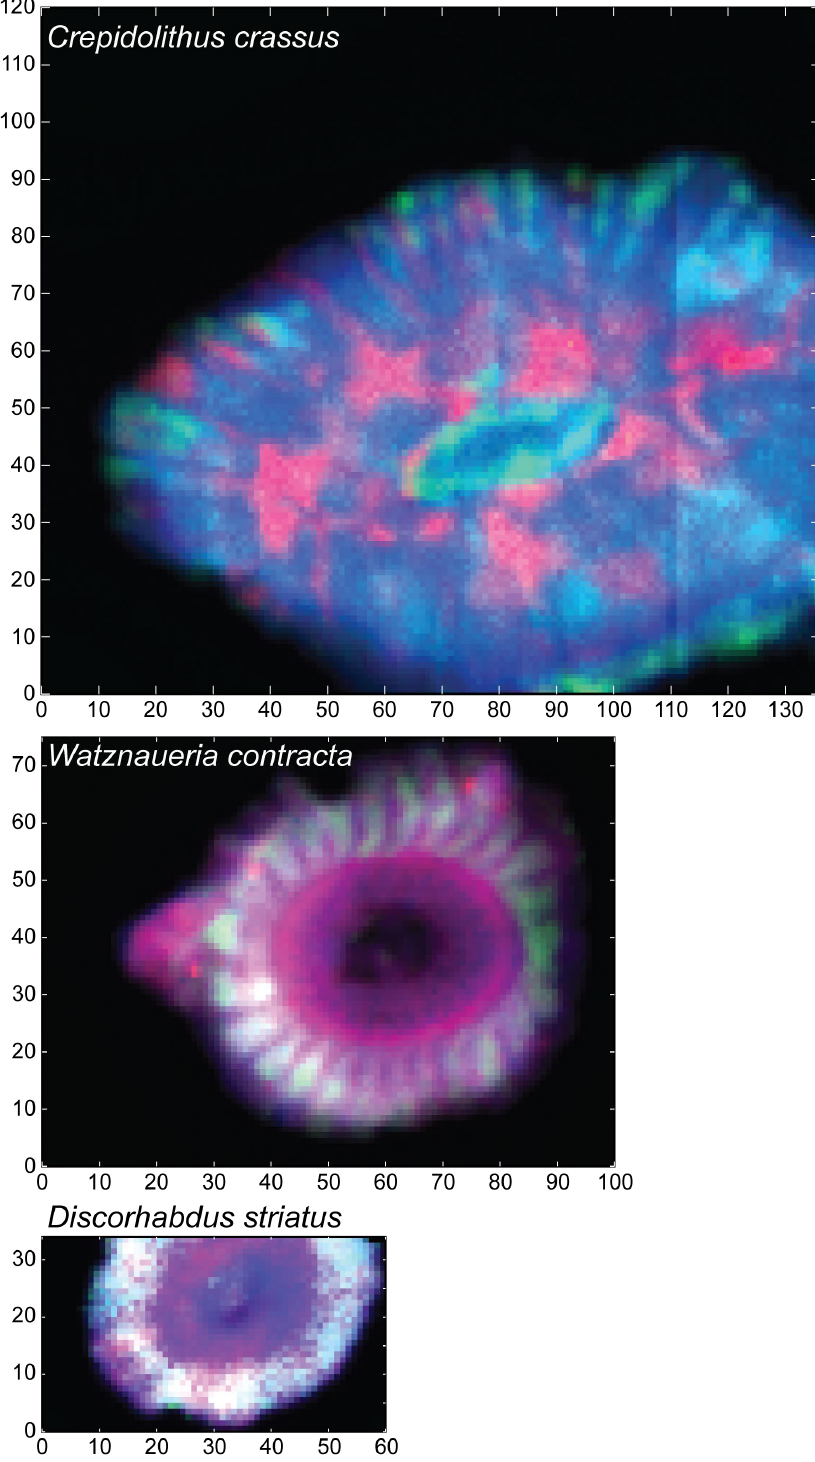
Supplementary Figure 1. Ca (blue), Sr (red) and Mn (green) maps (free scale cps) of C. crassus , W. contracta and D. striatus